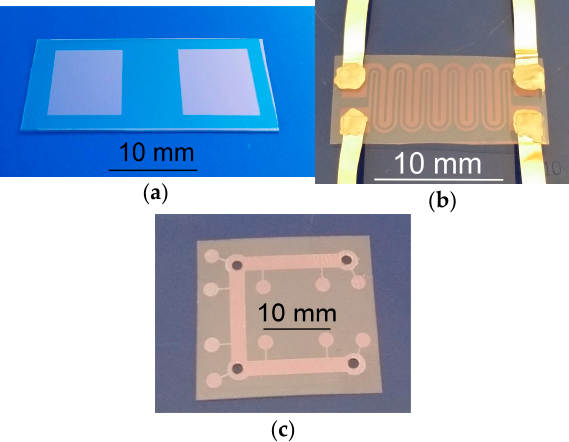
Figure 1. Examples of structures prepared by laser ablation: ( a ) electrodes for cryogenic sensors made in ITO layer on PEN substrate; ( b ) micro-heater in ITO/Ag/ITO layer with silver leads; ( c ) test structure for examination of electrical properties of ITO on PEN.